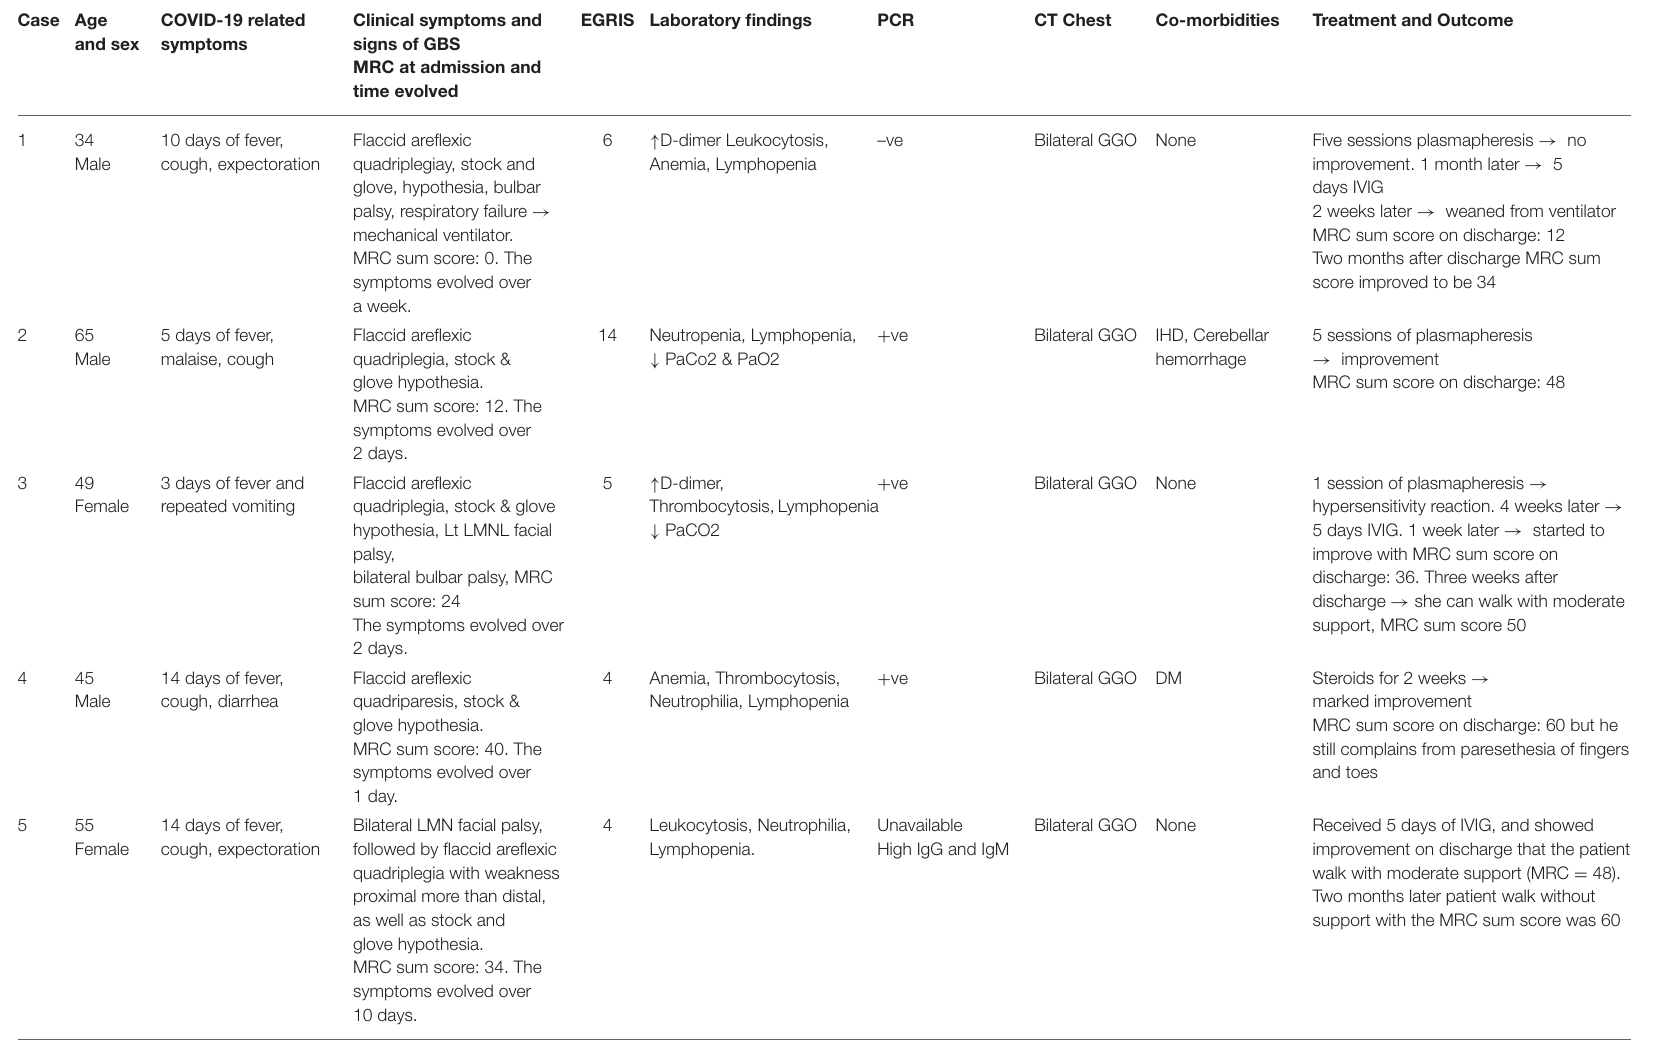
TABLE 1 | Clinical and laboratory